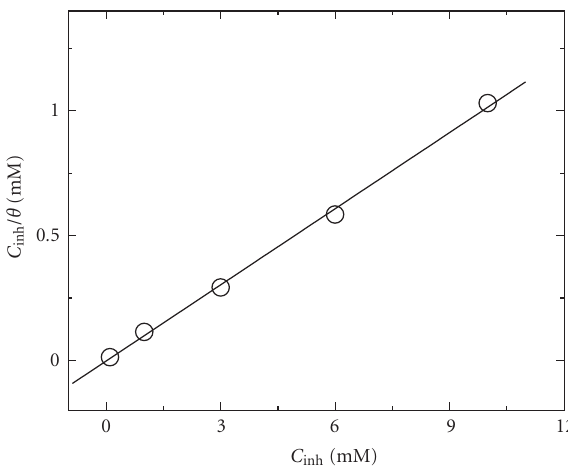
Figure 6: Plot of C inh /θ versus C inh following Langmuir adsorption